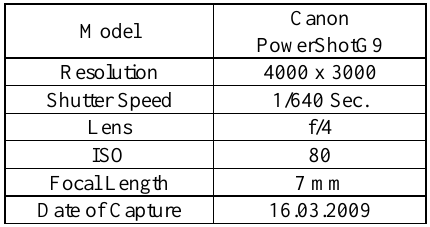
Table 2. Specification of digital camera